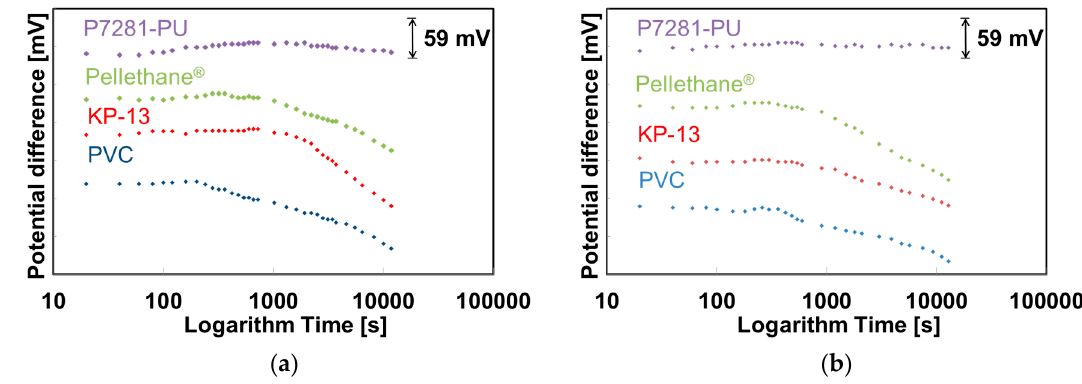
Figure A1. Initial drift of NO 3 -ISFETs in whole saliva. ( a ) Same data as Figure 3f; ( b ) for reproducibility check.